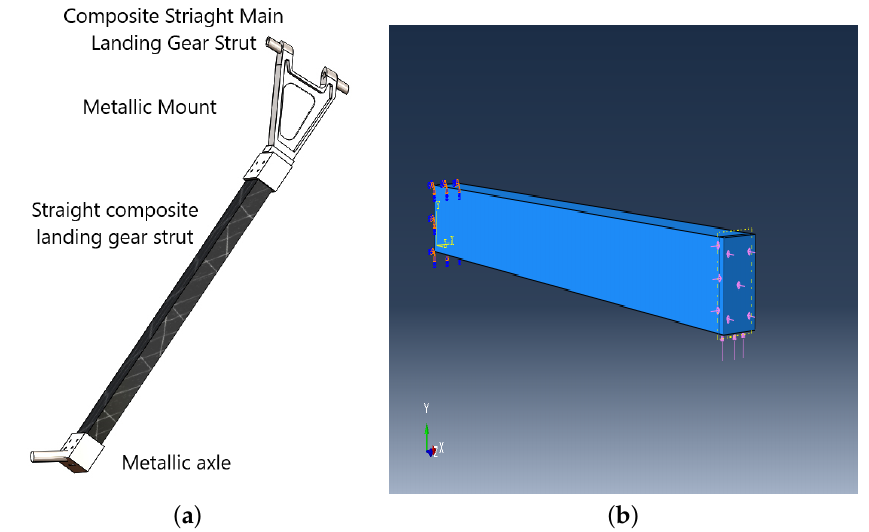
Figure 6. CAD Model and boundary conditions for S-glass fiber/epoxy and T300 carbon/epoxy straight main landing gear strut applied during the computational analysis using Abaqus CAE ® . ( a ) (CAD model for straight retractable composite main landing gear strut.). ( b ) Boundary conditions for S-glass fiber/epoxy and T300 carbon/epoxy straight main landing gear strut utilized during analysis.